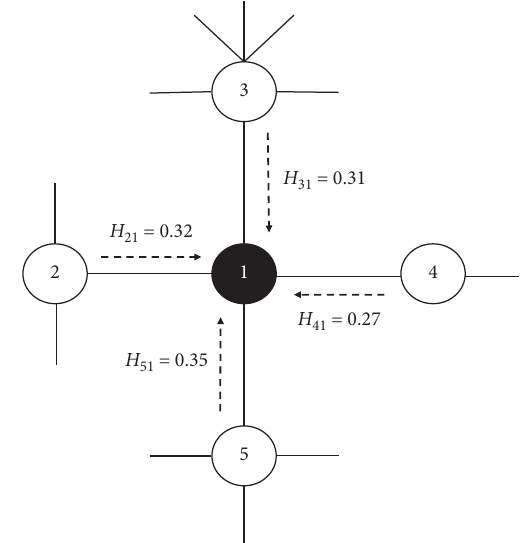
Figure 2: (Color online) The figure shows how to calculate the IIE. There are four neighbors for node 1. H is the information quantity. For example, H represents the information quantity provided 21 from node 2 to node 1. We set L � 1 and β � 0 . 2. Each data point is calculated from the average of 10 3